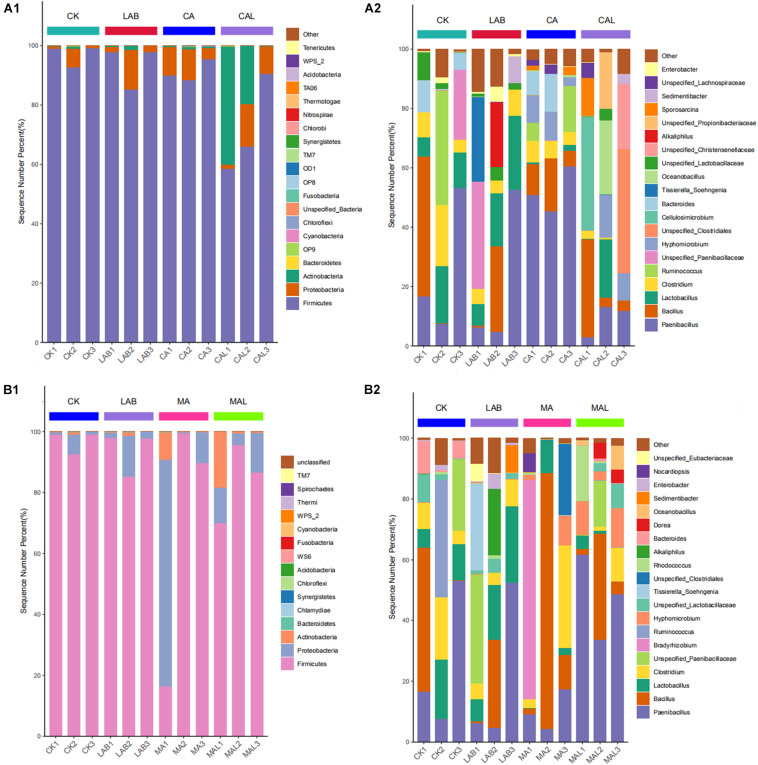
Relative abundances of the bacterial phyla (A1,B1) and genera (A2,B2) in CF silage treated with CA and Lactobacillus plantarum, or MA and Lactobacillus plantarum. CK, control; LAB, Lactobacillus plantarum; CA, citric acid; CAL, citric acid + Lactobacillus plantarum, MA, malic acid; MAL, malic acid + Lactobacillus plantarum.